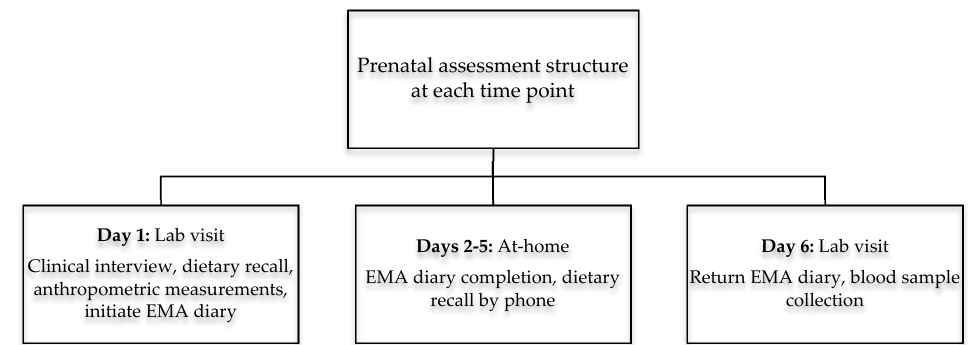
Figure 2. Structure of prenatal assessments in early (10–12 weeks), middle (20–22 weeks), and late (30–32 weeks) pregnancy.